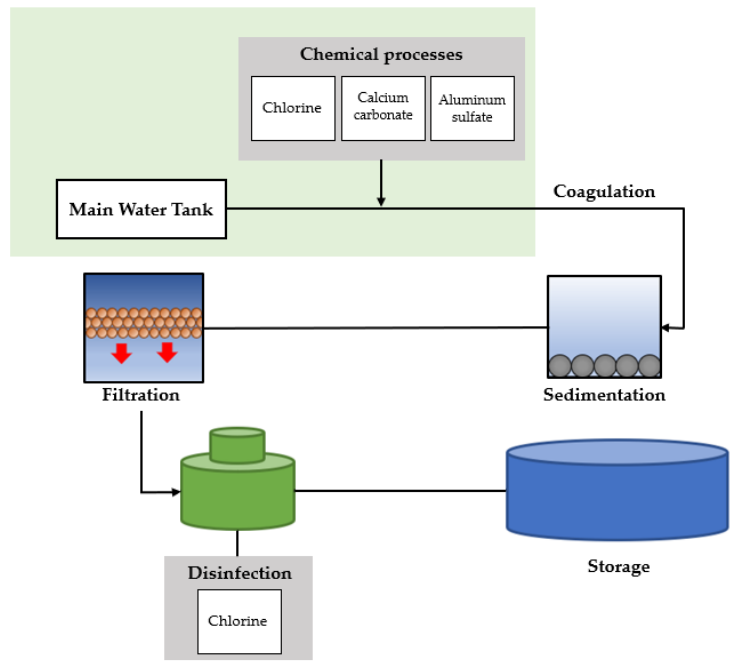
Figure 6. Water treatment process by the Pure Water Technology company. Figure 7. Water intake and chemical treatment phases.